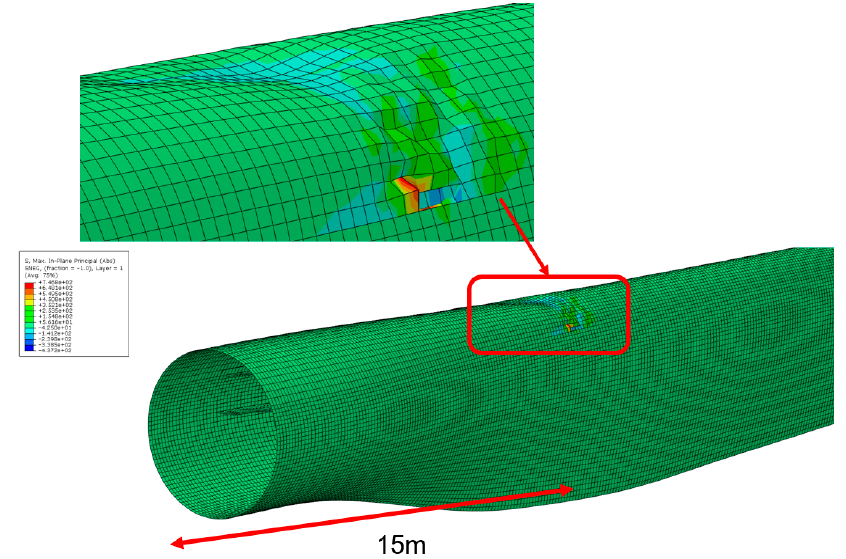
Figure 20. Crack growth shape depending on the wind blade scale and buckling risk: 200% of load scale.